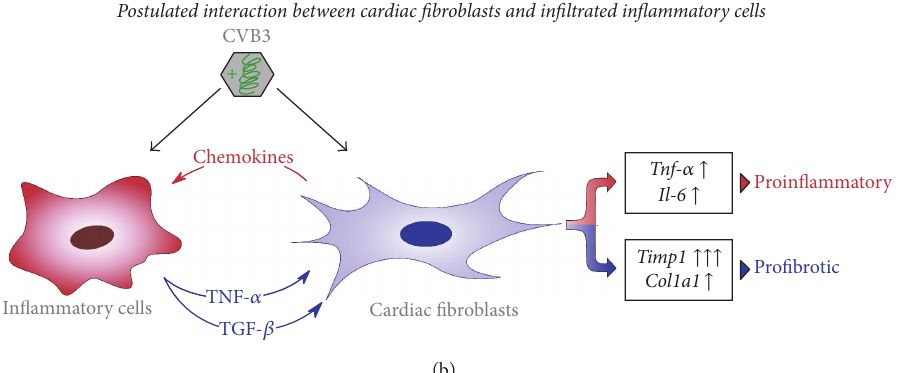
Figure 8: Proinflammatory and profibrotic effects of CVB3 infection in murine heart tissue. (a) Serial cross sections of the left ventricle from healthy or CVB3-infected C57BL/6J mice were stained with hematoxylin/eosin or for COL-I. During acute myocarditis (7 days p.i.) infiltrated cells appear in the cardiac tissue clearly seen as foci of inflammation which are consistently colocalized with fibrosis, shown by COL-I staining. (b) Suggested interaction scheme of cardiac fibroblasts and inflammatory cells in CVB3-induced viral myocarditis. CVB3 infection of cardiac fibroblast alone did not result in profibrotic signaling but increased chemokine and cytokine expression was detected. Elevated chemokine levels might be one regulator to induce the recruitment of inflammatory cells into the infected cardiac tissue. In turn, the induced expression of TGF- 𝛽 in CVB3-infected macrophages might be one key player to induce profibrotic gene expression in cardiac